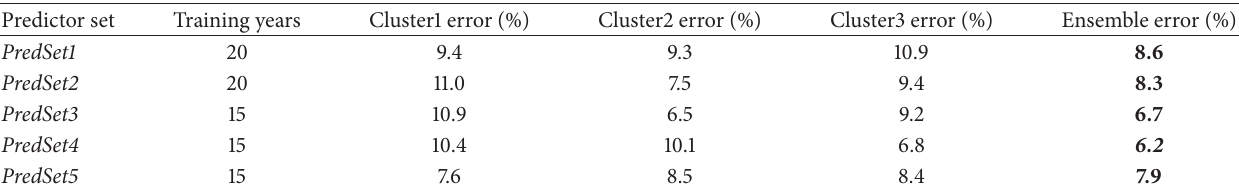
Table 5: Mean absolute errors (%) for annual Indian summer monsoon rainfall prediction by individual MR cluster models and ensemble model for test period 2001–2013. Reports minimum error of 6.2 %.